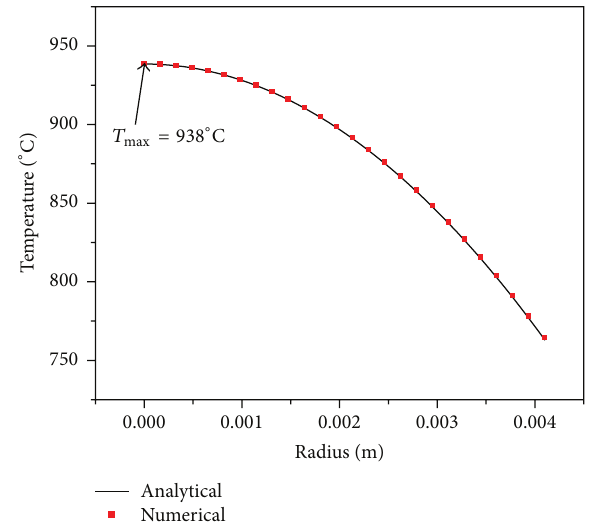
Figure 6: Steady state temperature distribution along the centre of fuel pin.